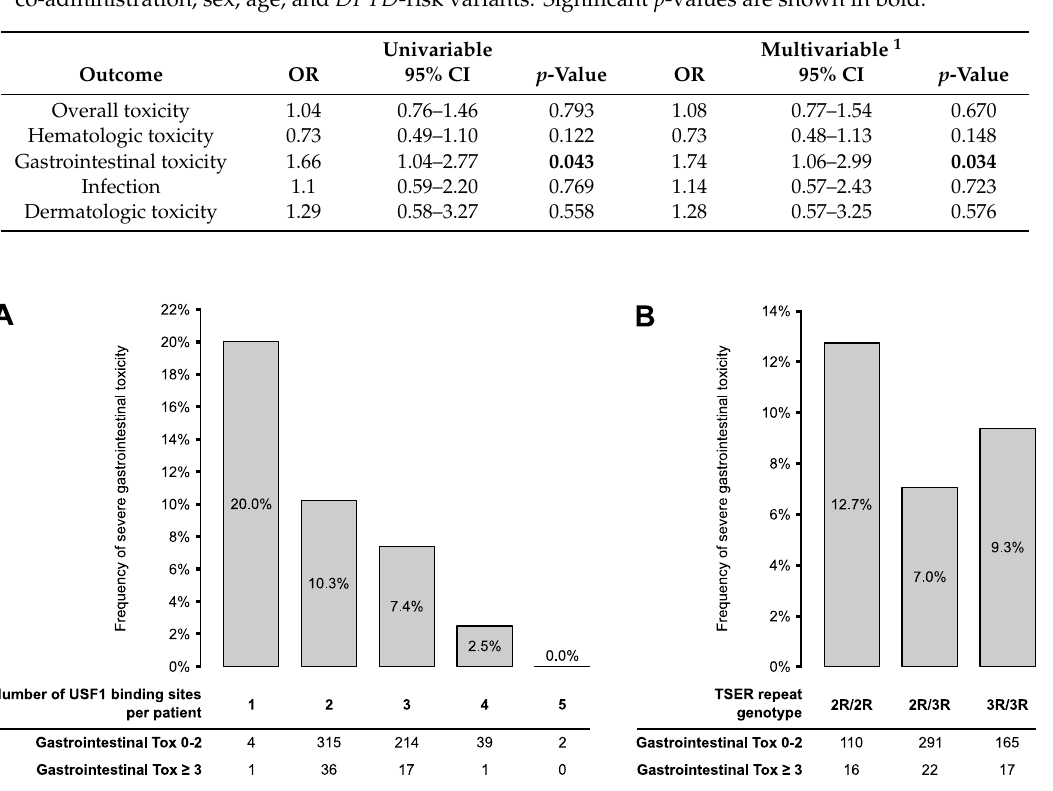
Table 3. Toxicity association with number of USF1-binding sites. Associations were assessed in the full cohort ( n = 629). p -values from logistic regression models; 1 adjusted for cis-and carboplatin co-administration, sex, age, and DPYD -risk variants. Significant p -values are shown in bold.